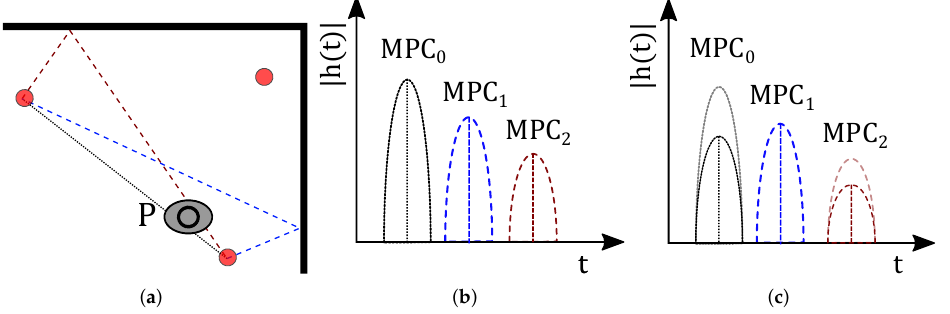
Figure 1. Principle of MA-RTI for UWB CIR measurements. ( a ) Concept of MA-RTI. ( b ) CIR when the target area is empty; idle case. ( c ) CIR when the person is located within the target